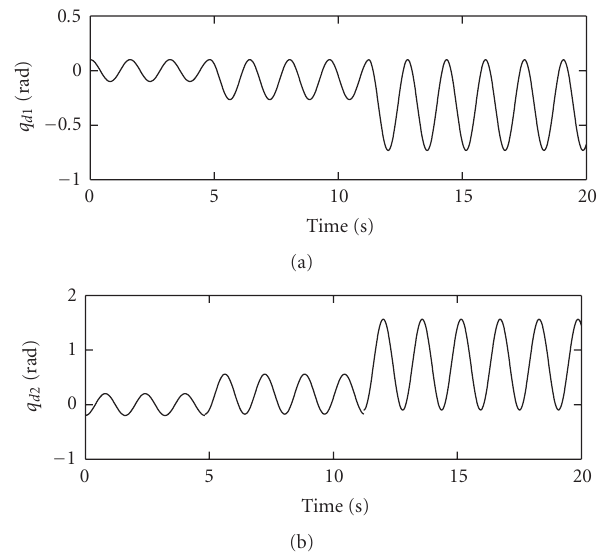
Figure 1: Plot of desired trajectories for Acrobot by selecting several values of φ